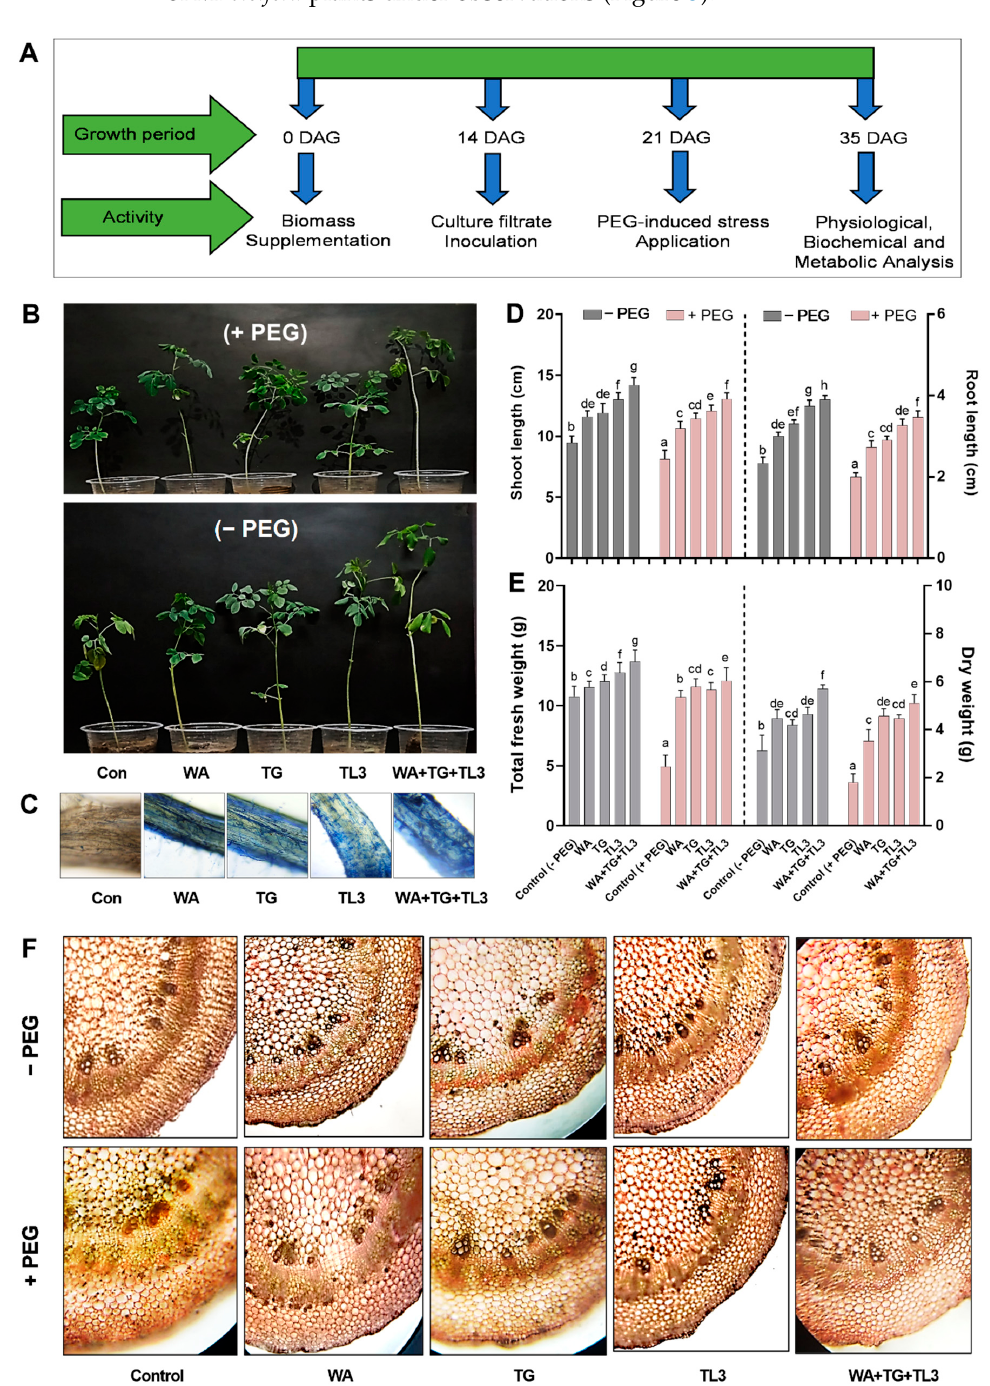
Figure 5. Effect of WA, TG, and TL3 inoculation on M. oleifera plant growth. ( A ) Schematic representation of the M. oleifera plant bioassay, ( B ) phenotypic analysis; upper penal (plants supplemented with PEG) and lower penal (plants without PEG supplementation), ( C ) root colonization by fungal endophytes, ( D ) shoot length (right penal), and root length (left penal), ( E ) total fresh weight (right penal), and total dry weight (left penal), ( F ) stem anatomical features. Quantitative data represent means ± SE of three independent biological replicates presented with various letters showing differences at a significance level of p ≤ 0.05 using Duncan’s multiple range test (DMRT).